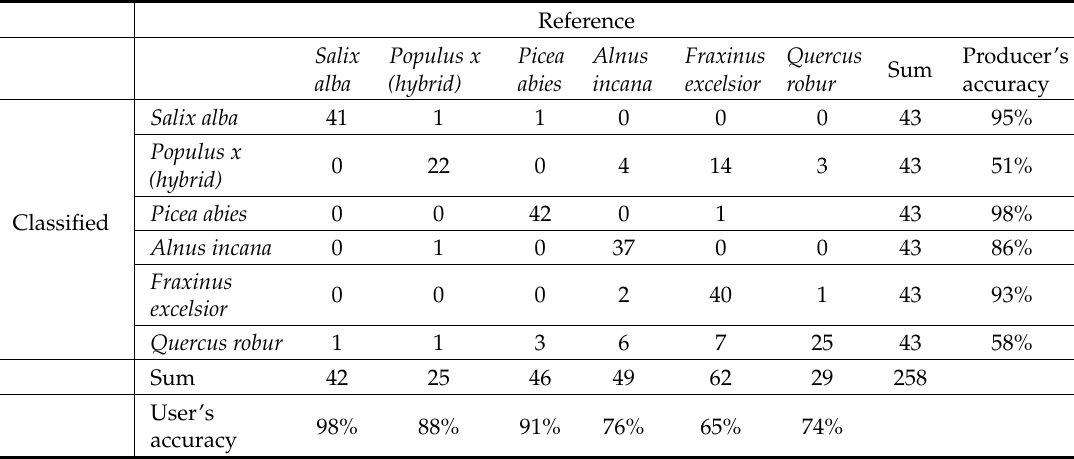
Table A2. The accuracy assessment using the APEX hyperspectral imagery with the square root of 268 (16.37, which was rounded to 17) as an input to the RF algorithm.